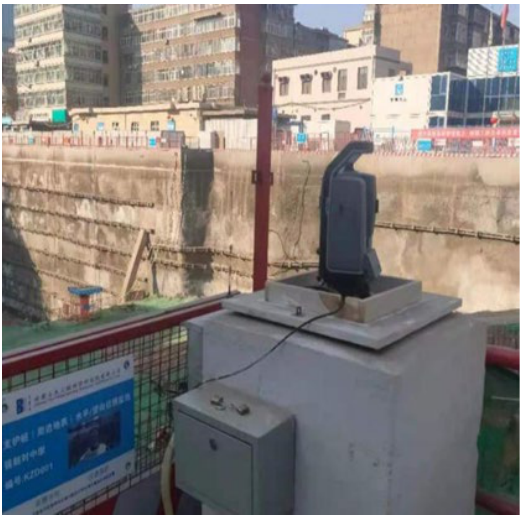
Figure 11. Ten Pao S9 measuring robot.